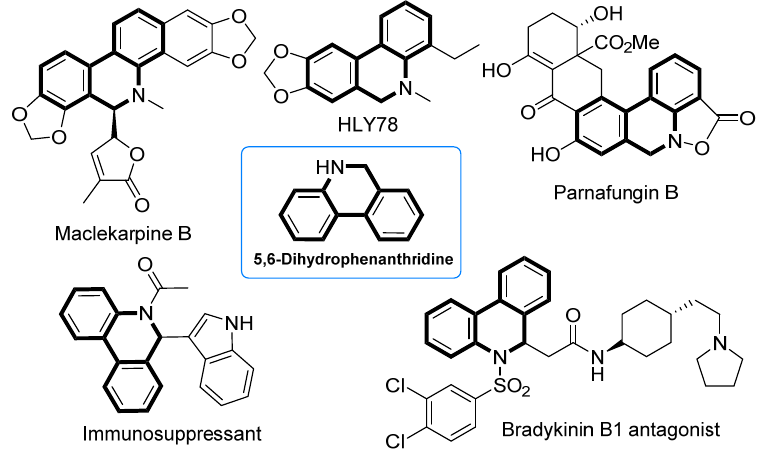
Figure 1. Natural products and drugs containing 5,6 ‐ dihydrophenidine skeleton.